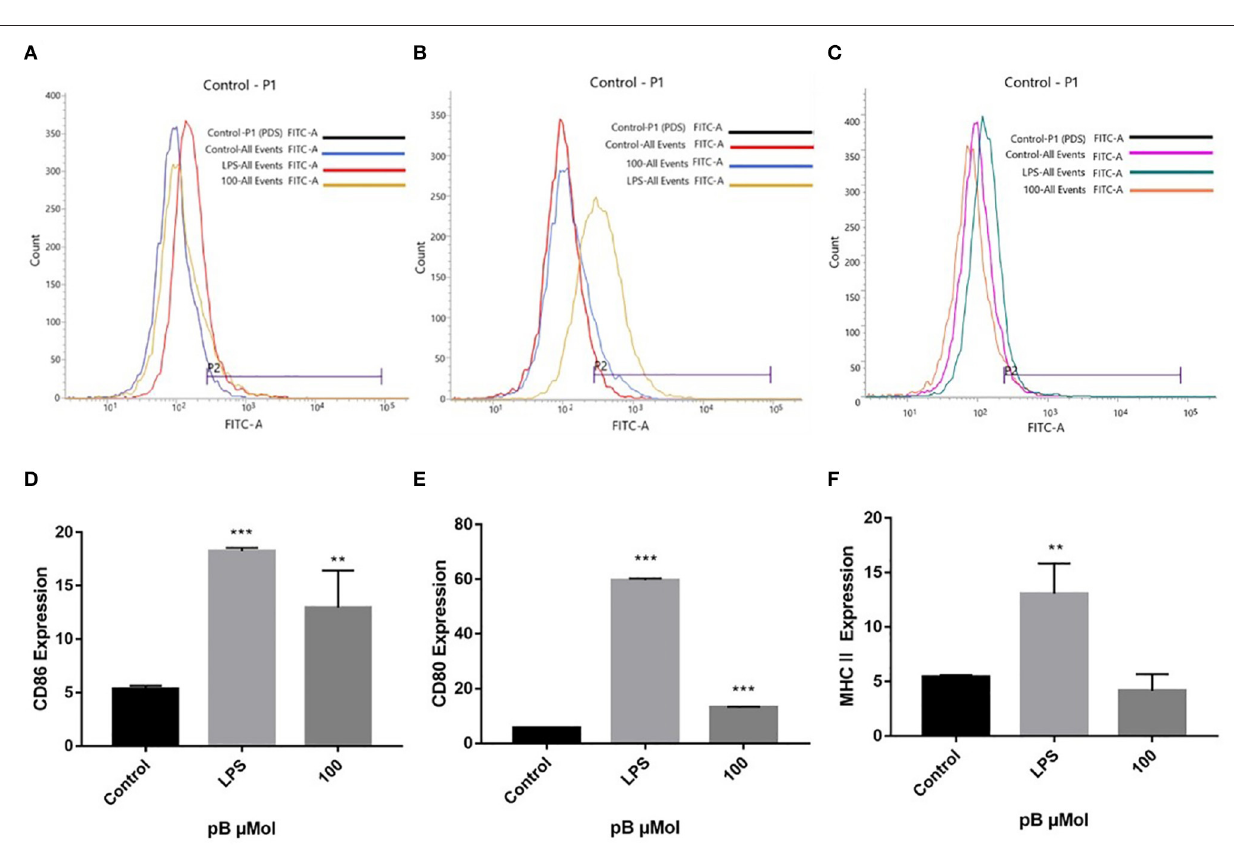
FIGURE 8 | Flow cytometric analysis of CD86, CD80, and MHC II expressions on the surface of RAW264.7 cells. (A,D) represent the results of CD86 expression. (B,E) represent the results of CD80 expression. (C,F) represent the results of MHC II expression. Data presented are the mean ± SD, n = 3. Compared with the control, *** p < 0.001 and ** p <